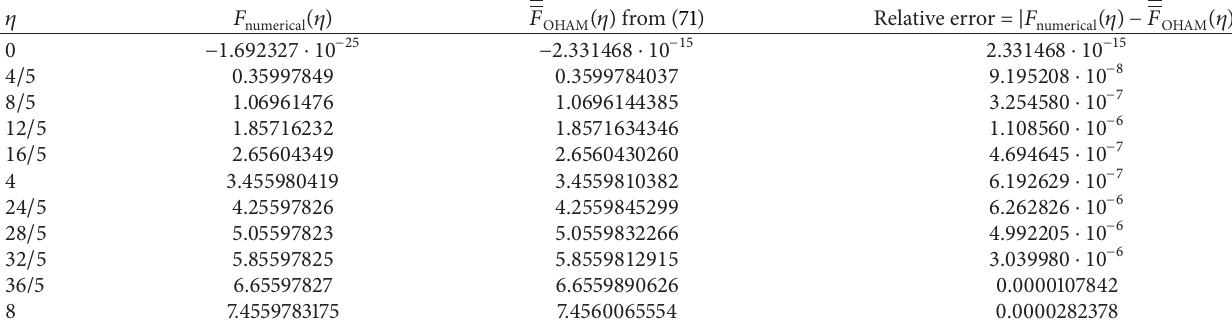
Table 25: Comparison between OHAM results given by (71) and numerical solutions for 𝛽 = 1.6 .